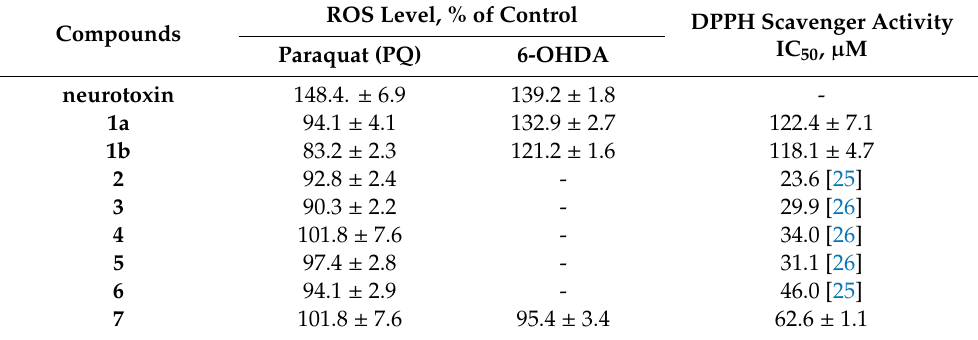
Table 1. Antioxidant activities of compounds 1 – 7 in cell-based and cell-free assays. ROS Level, % of Control Compounds